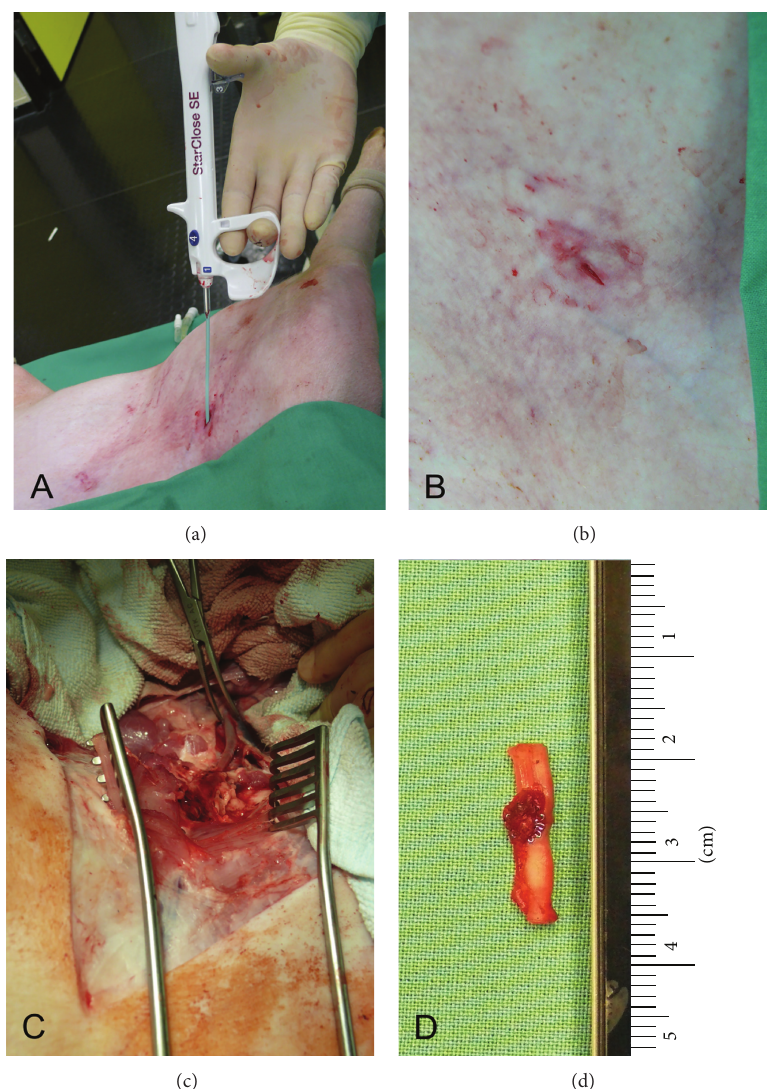
Figure 1: (a) Application of the VCD in pigs right FA. (b) No bleeding after application of the VCD. (c) Only subtle subcutaneous bruising and no significant hematoma visible in dissection of the right groin. (d) Right FA specimen with metallic clip affixed to the vessel